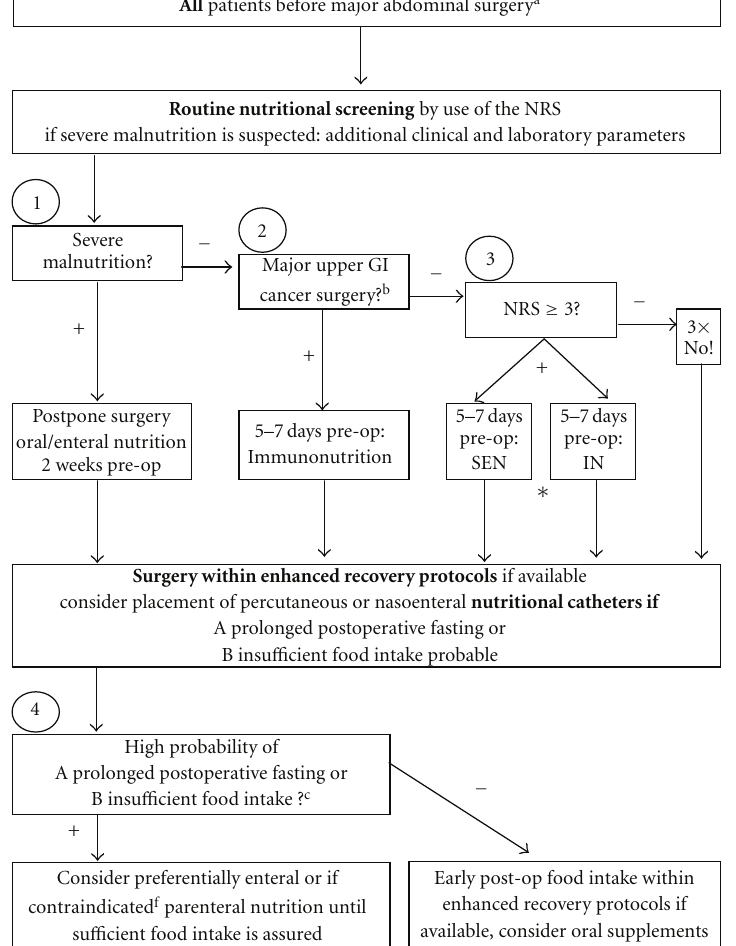
Figure 1: Pragmaticalgorithmfor preoperative nutritional screening and perioperative nutrition in digestive surgery. The algorithmresumes perioperative care in terms of nutrition in major abdominal surgery. It is largely based on recent systematic reviews and guidelines on perioperative nutrition [26, 27] and enhanced recovery [32]. a Major abdominal surgery includes colorectal, gastric, liver, pancreatic, and esophageal resection for benign and malignant disease by either laparotomy or laparoscopic approach, lasting usually > 2h. b Major upper GI surgery indicating preoperative IN regardless of nutritional status include oesophageal, gastric and pancreatic resection for cancer [26]. c defined as anticipated perioperative starving > 7 days and oral intake < 60% of recommended for > 10 days [26]. NRS: Nutritional Risk Score; pre-OP: pre-operative, IN: immunonutrition, SEN: standard enteral nutrition (usually whole protein formula). ∗ currently evaluated by (http://www.clinicaltrial.gov; trial #